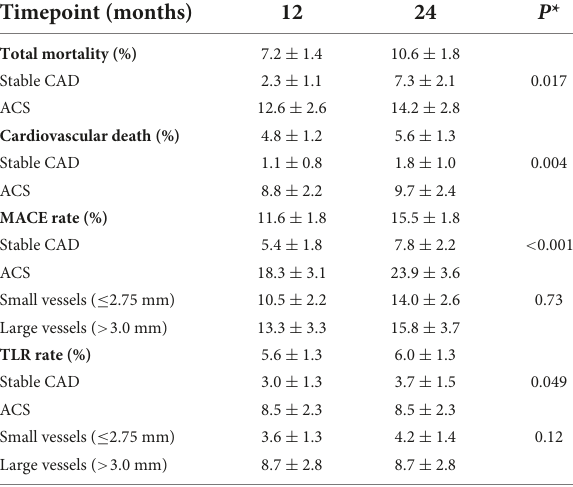
FIGURE1 (A) Cumulative major adverse cardiac events (MACE) rate